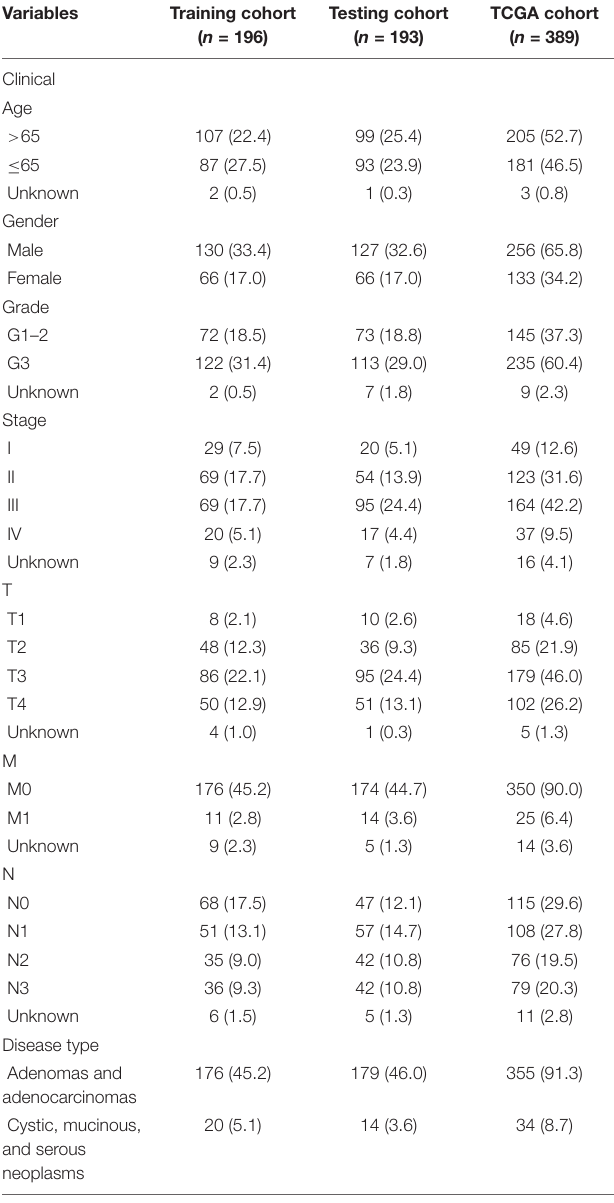
TABLE 1 | Clinical information of 389 TCGA GC